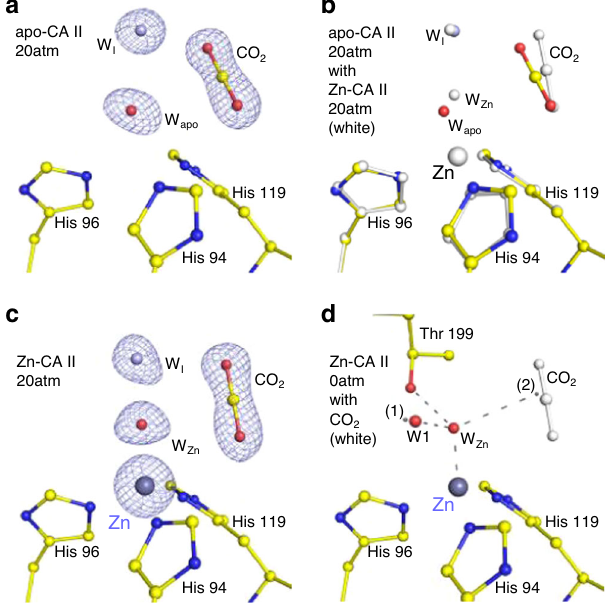
Fig. 3 Substrate/product binding in apo- and Zn-CA II. The intermediate water (W I ) is colored in steel blue for clarity. The electron density (2F o – F c , blue) is contoured at 2.2 σ . a , b At 20 atm of CO 2 pressure, apo-CA II shows clear binding of CO 2 without the need of Zn 2 + ion. c Zn-CA II shows similar binding of CO 2 as in apo-CA II while maintaining tetrahedral metal coordination. d Upon CO 2 binding (white) in Zn-CA II, W Zn is located at the center of the hypothetical tetrahedral arrangement made up of Zn 2 + ion, Thr199-O γ 1, position (1) (close to W1), and position (2) (close to the carbon atom in CO 2 ). In this con fi guration, a hybridized lone pair in W Zn directly faces CO 2 molecule at a distance, appropriate for ef fi cient nucleophilic attack. Distance between the position (2) and C atom of CO 2 is merely 0.36